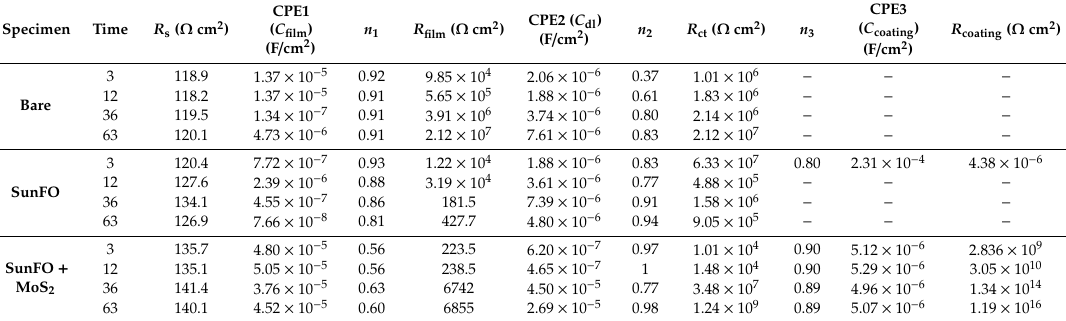
Table 2. EIS results of specimens according to the coating materials. Specimen